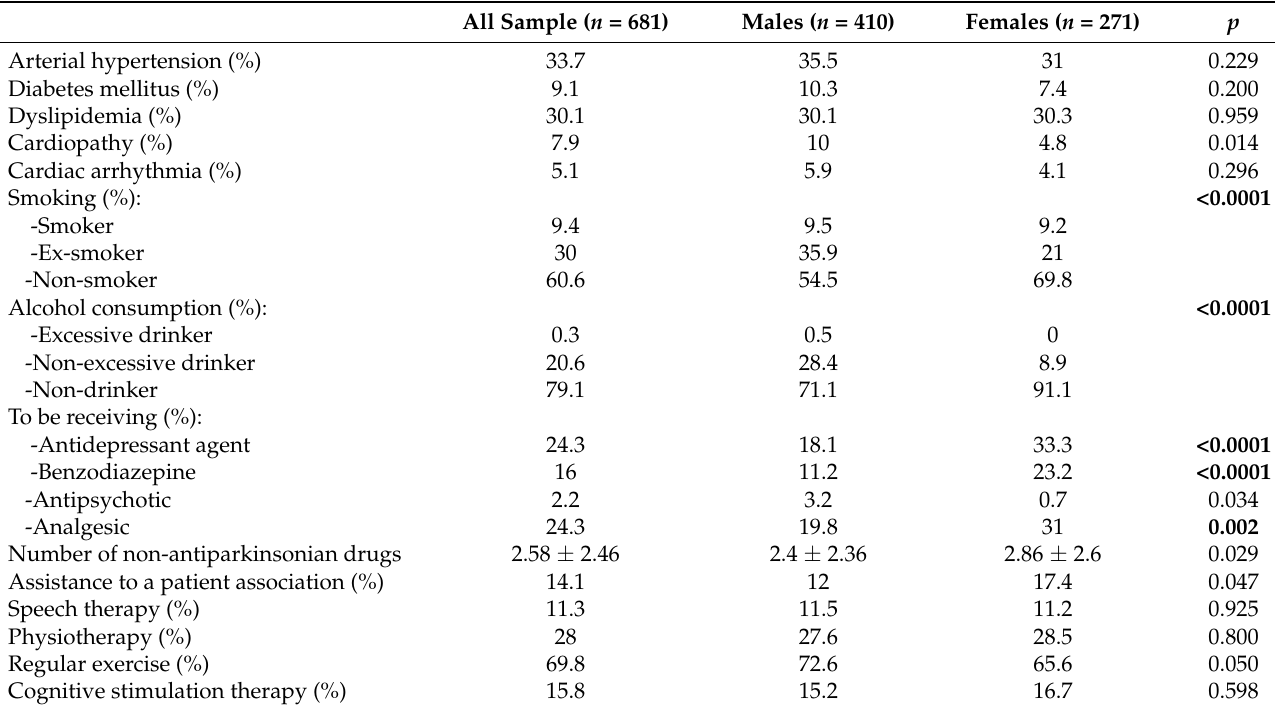
Figure 1B). The results regarding global, fronto-subcortical, and posterior cortical cognitive function as a whole were similar in both groups (Table 3). The perception of health-related QoL (PDQ-39SI, 18.88 ± 13.76 vs. 16.05 ± 13.33;